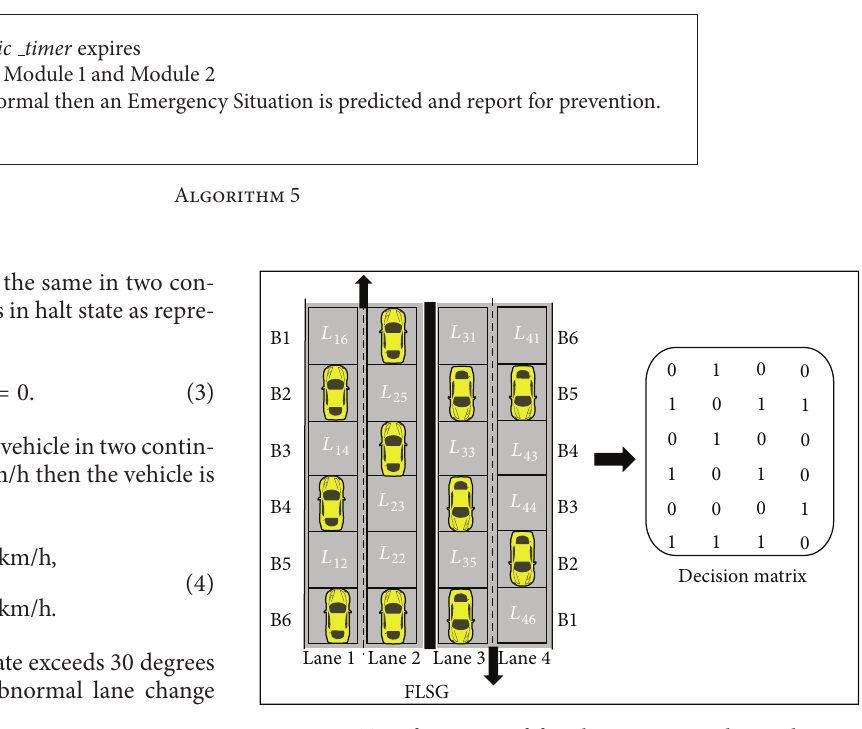
Figure 6: Transformation of four-lane sensor grid into decision